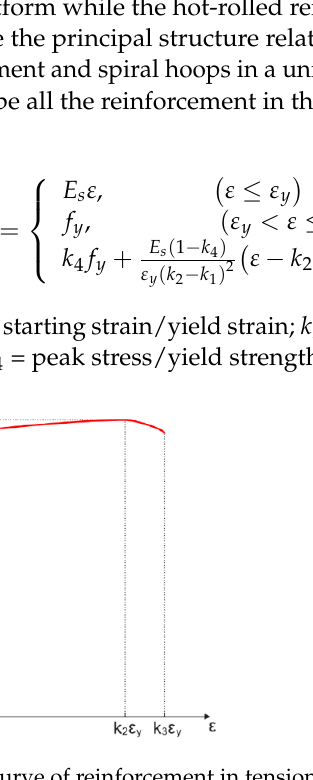
Figure 7. Stress-strain curve of reinforcement in tension.